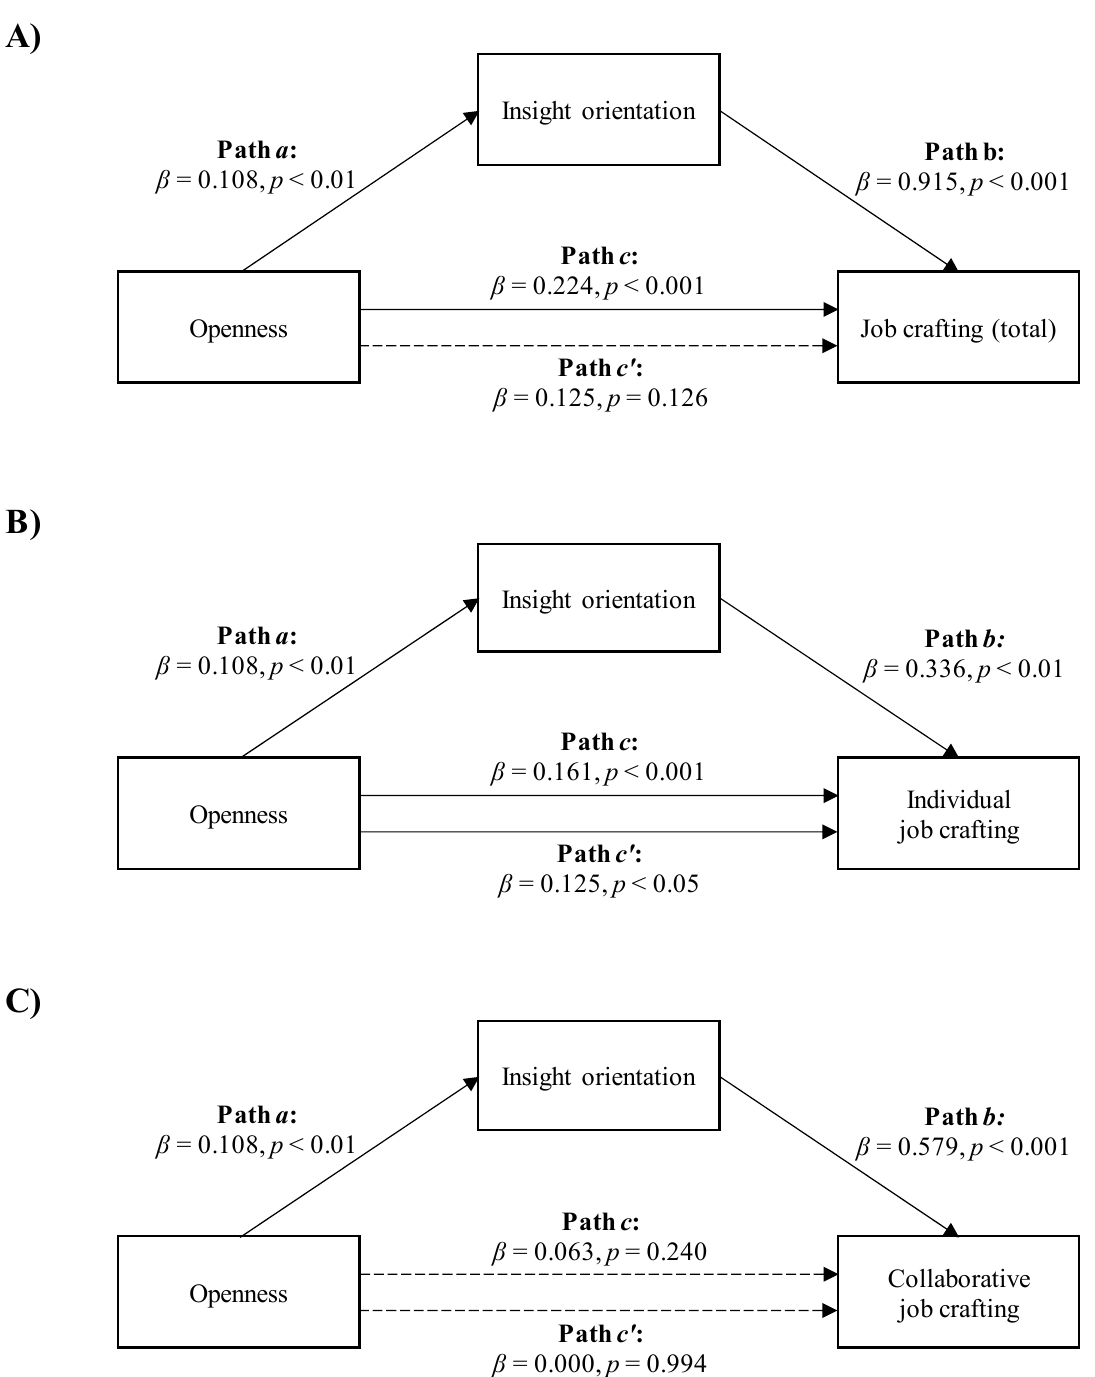
Figure 5. The mediation of insight orientation in the relationships between openness and total job crafting score. ( A ) R 2 mediator effect size = 0.09, ( p < 0.05), individual job crafting ( B ) R 2 mediator effect size = 0.06, ( p < 0.05) or collaborative job crafting; ( C ) no mediation.